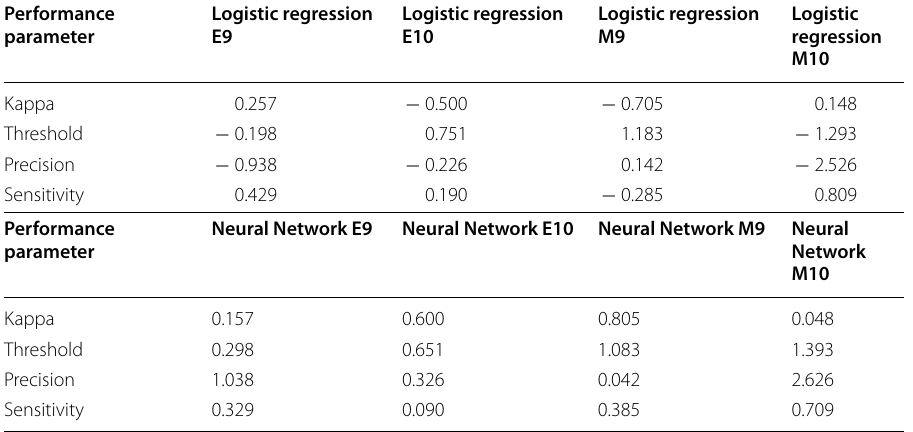
Table 7 Performance parameters, precision, and sensitivity of the decision tree models Performance